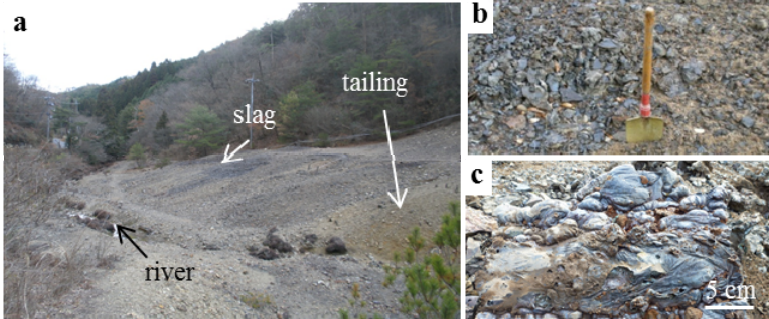
Figure 2. Photographs of ( a ) waste dumpsite, ( b ) fractured slag, and ( c ) coherent slag on the